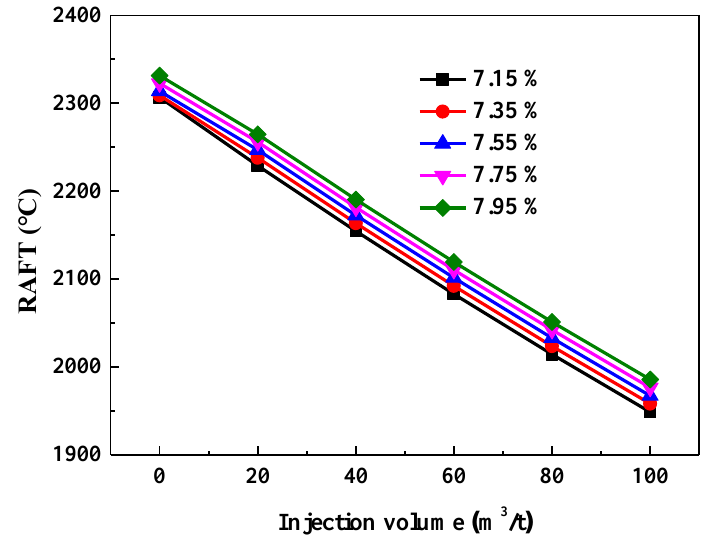
Figure 12. Effect of NG injection on RAFT under different oxygen enrichment rates.